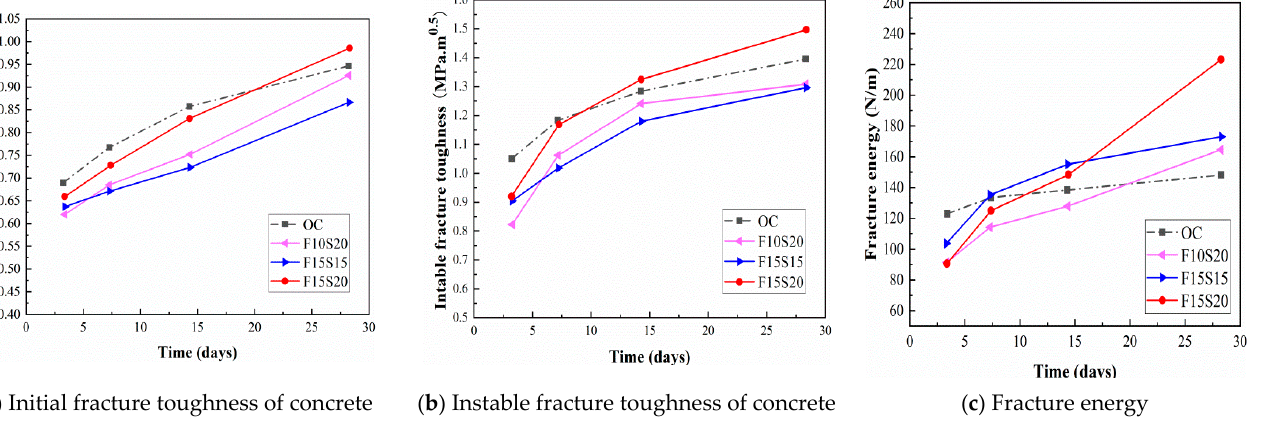
Figure 10. Fracture performance index of concrete with age: ( a ) initial fracture toughness of concrete; ( b ) unstable fracture toughness of concrete; ( c ) fracture energy.